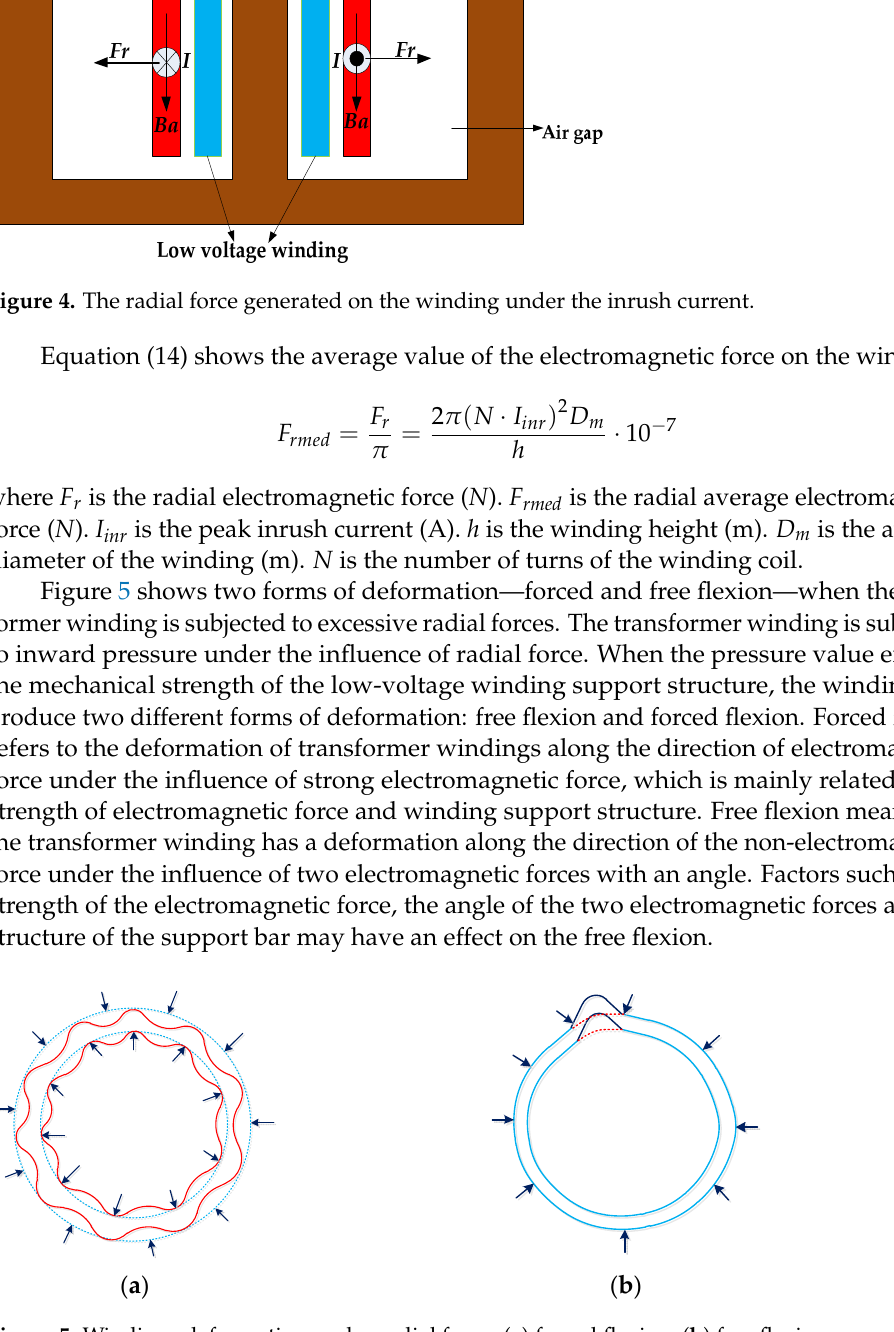
Figure 4. The radial force generated on the winding under the inrush current.